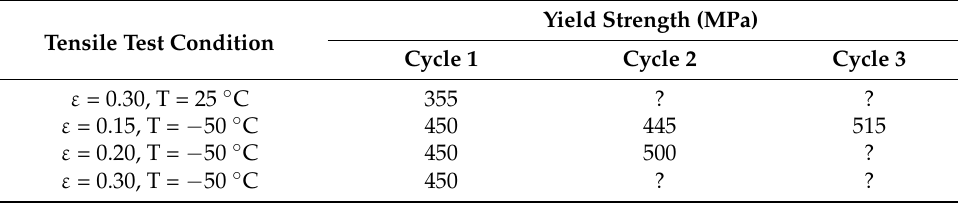
Table 5. Yield strength of 301 stainless steel